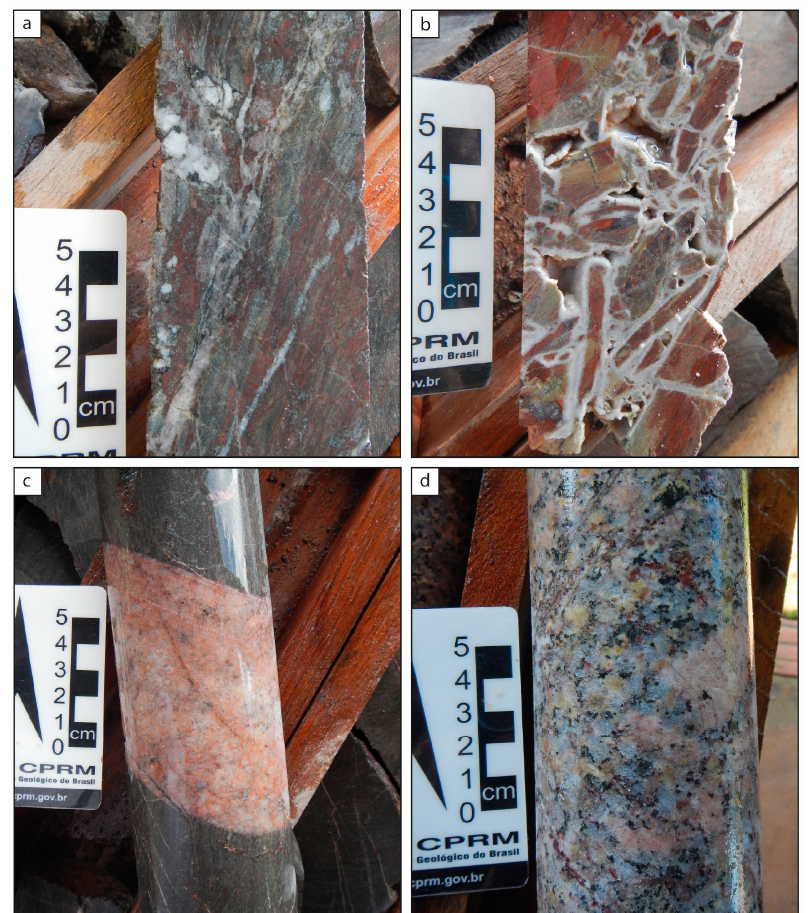
Figure 12. ( a ) Intensely altered metagrawacke (Abacaxis Fm.) exhibiting quartz veinlets concordant and discordant with foliation in JED–04 at 71 m. ( b ) Breccia with drusiform quartz and open cavities, in JED–04 at 75.5 m. ( c ) Sharp contacts between granite apophysis and the volcano-sedimentary basement, in JED–06 at 297.5 m. ( d ) Chuim granite partially altered by sericite, epidote, biotite, and hematite, in JED–05 at 70.8 m.